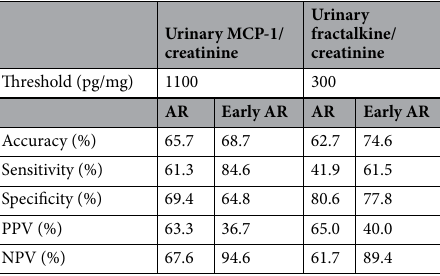
Table 2. The sensitivity analyses for post-KT 1 week urinary MCP-1 and fractalkine. AR acute rejection, KT kidney transplantation, MCP-1 monocyte chemoattractant protein-1, NPV negative predictive value, PPV positive predictive